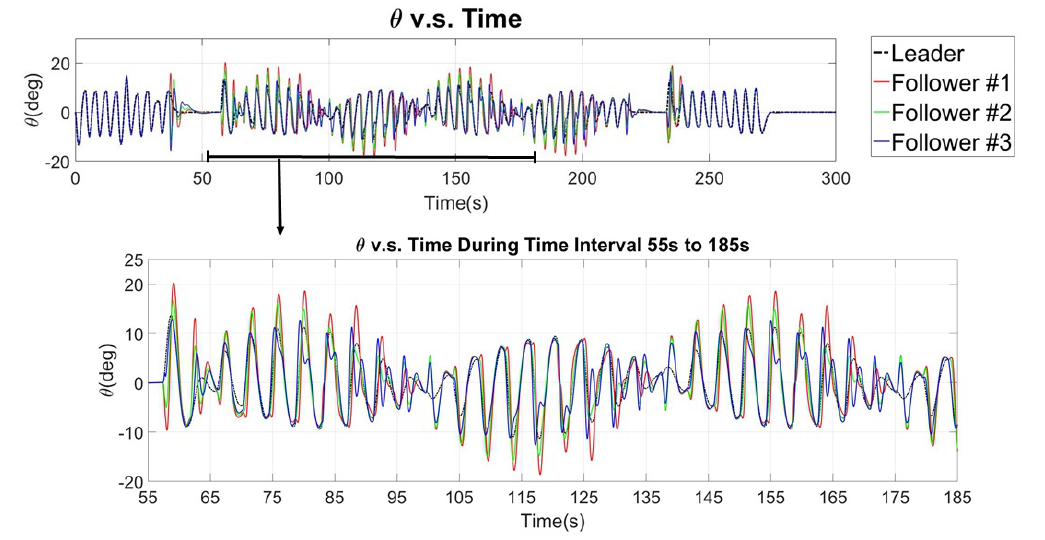
Figure 17. Quadrotor pitch angle throughout the comprehensive